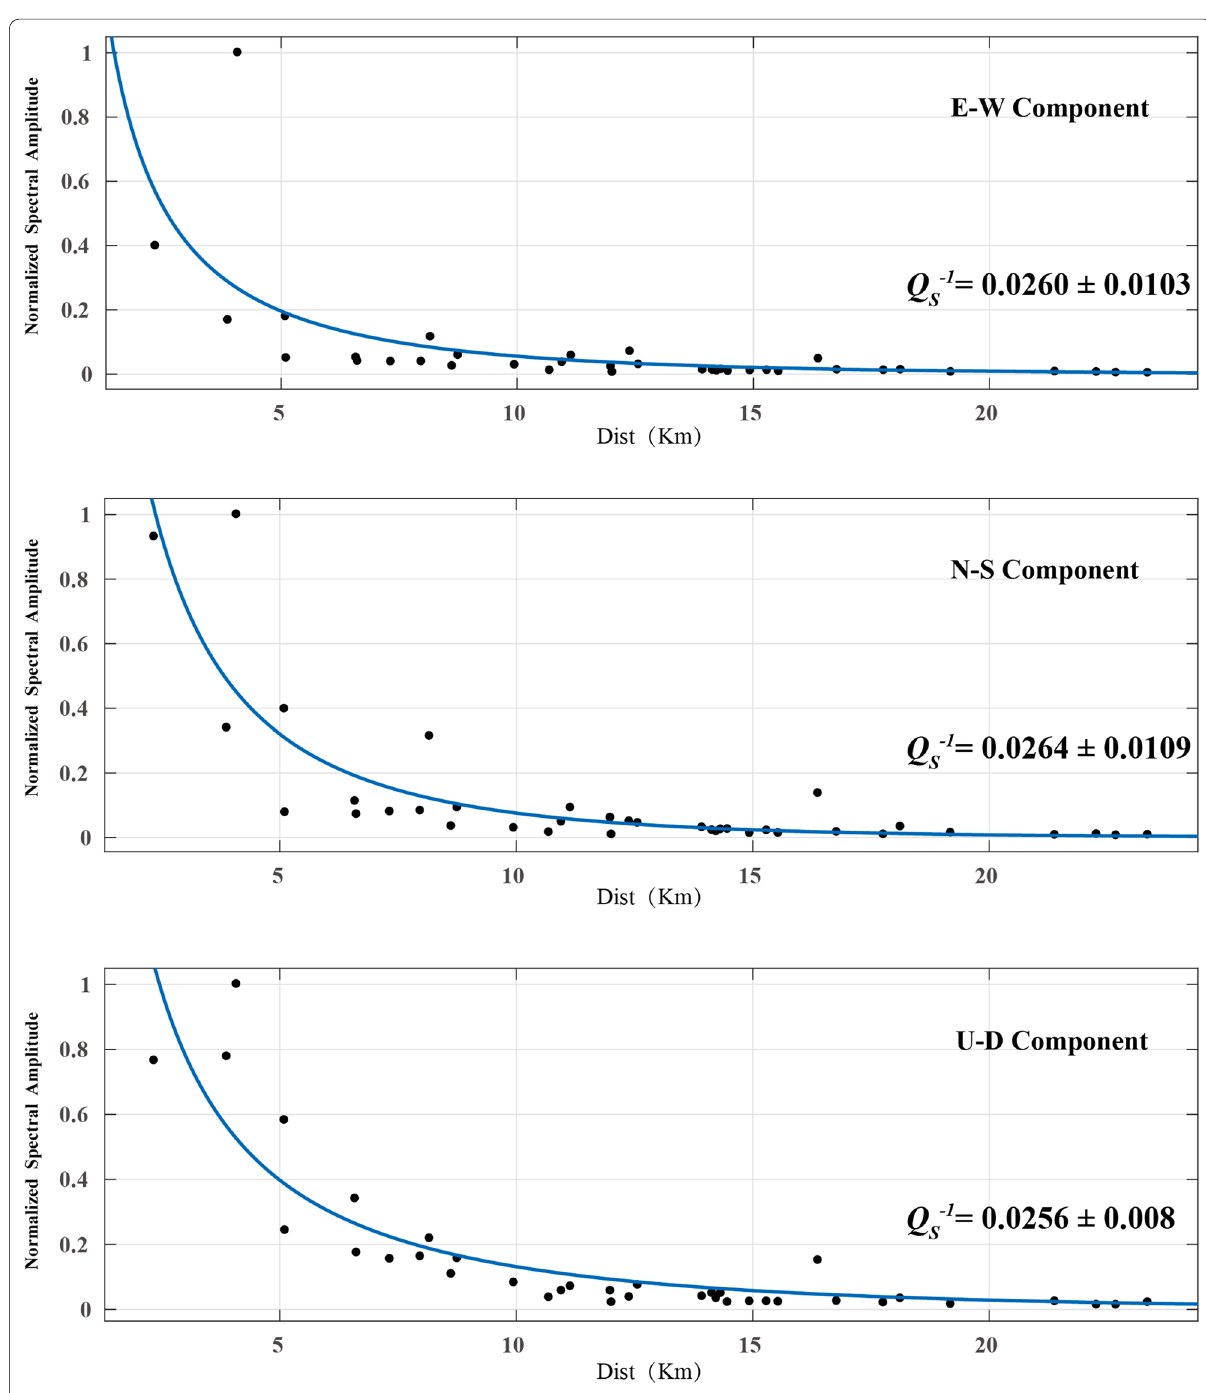
Fig. 8 Normalized spectral amplitudes of the signal. The black dots indicate the normalized spectral amplitudes at each station. The blue solid line shows the approximation curve from Eq. 1. The numbers written in each frame are the Q − 1 s